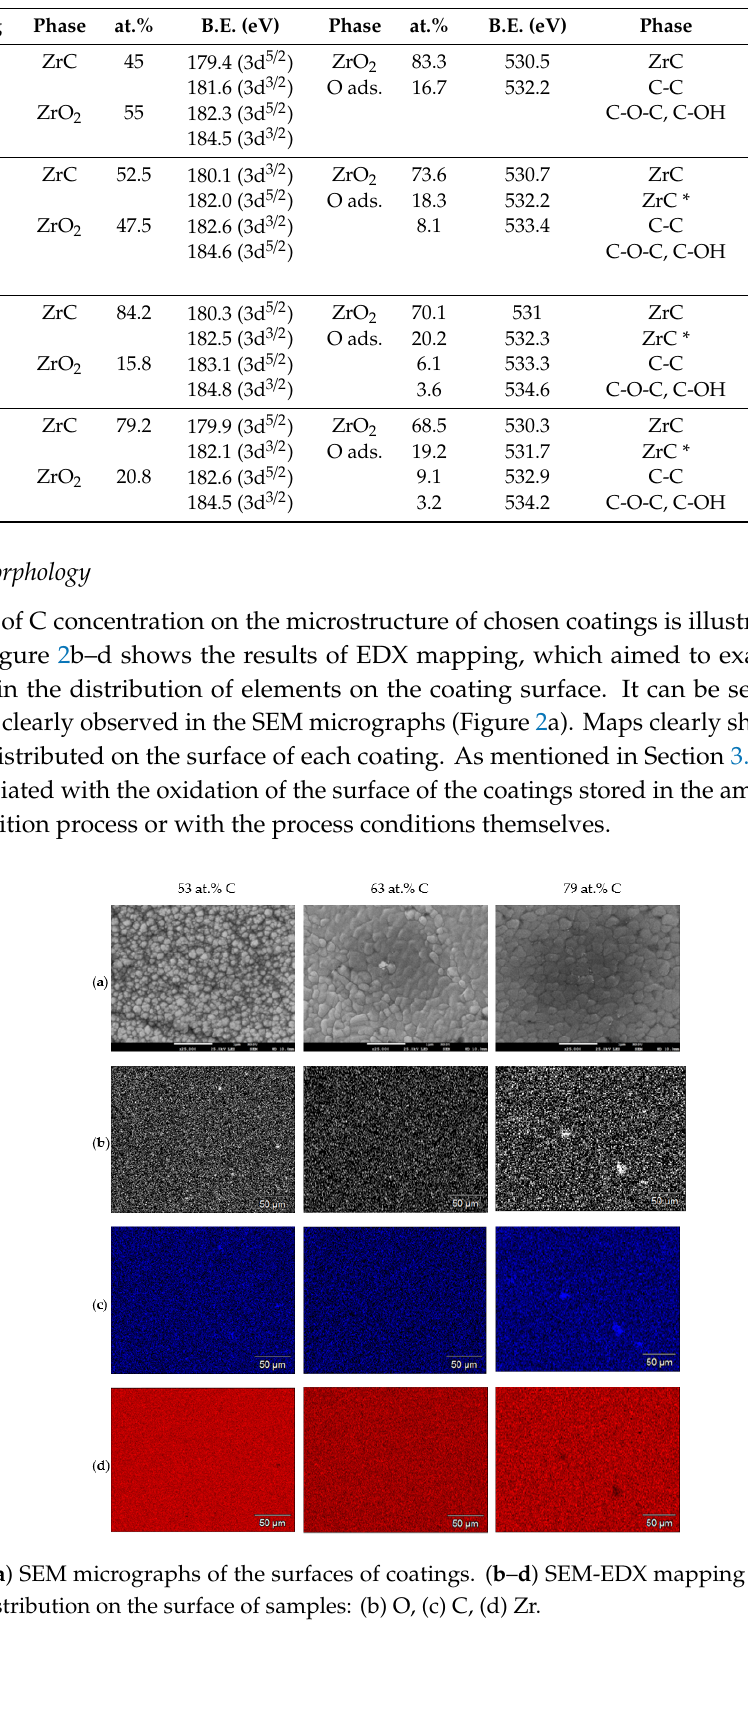
Table 3. Binding energies calculated from the deconvolved XPS spectra.